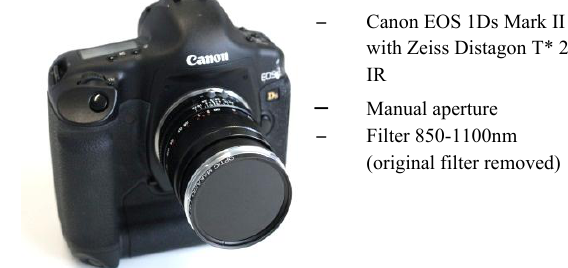
Figure 3. Properties of the near infrared sensitive camera